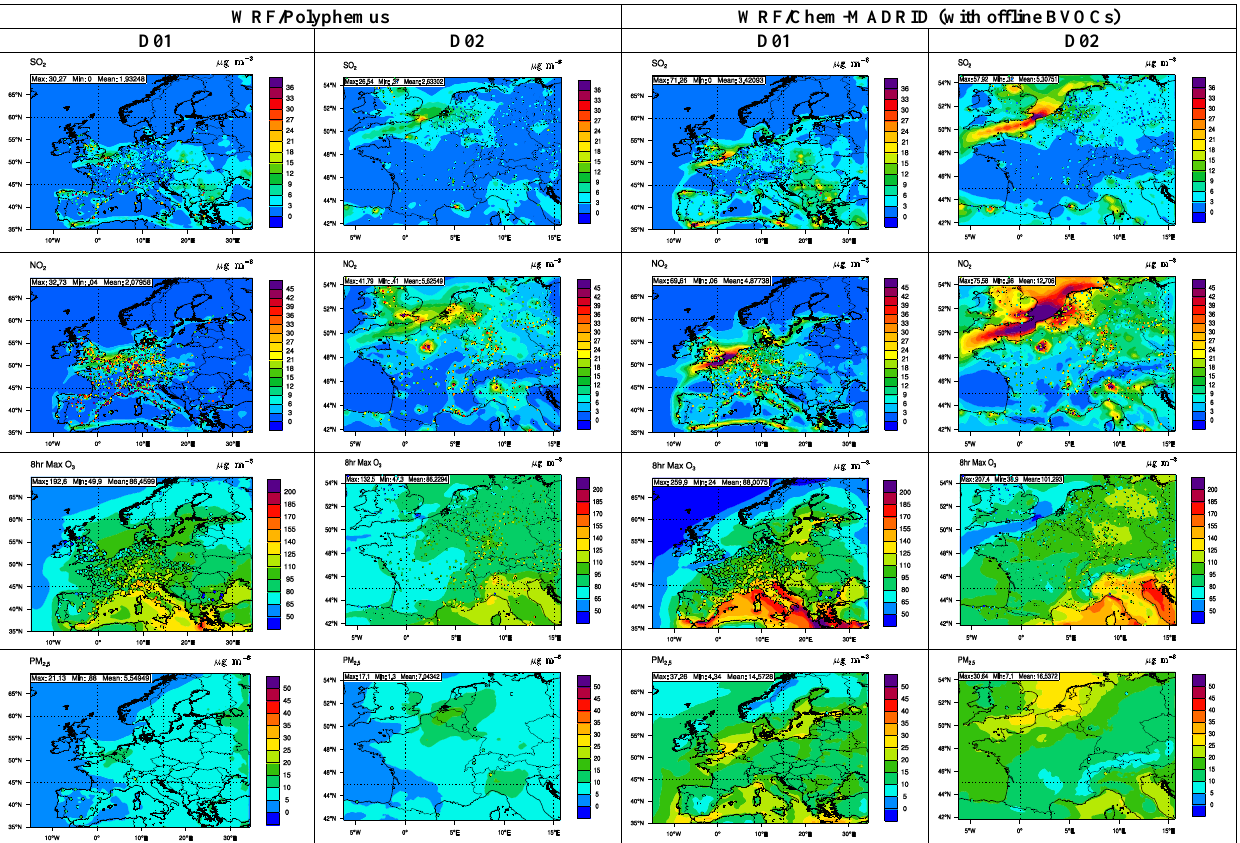
Figure 1. Simulated concentrations of SO 2 , NO 2 , maximum 8-hr O 3 , and PM 2.5 by WRF/Chem-MADRID and WRF/Polyphemus overlaid with observations in July 2001 over D01 and D02.